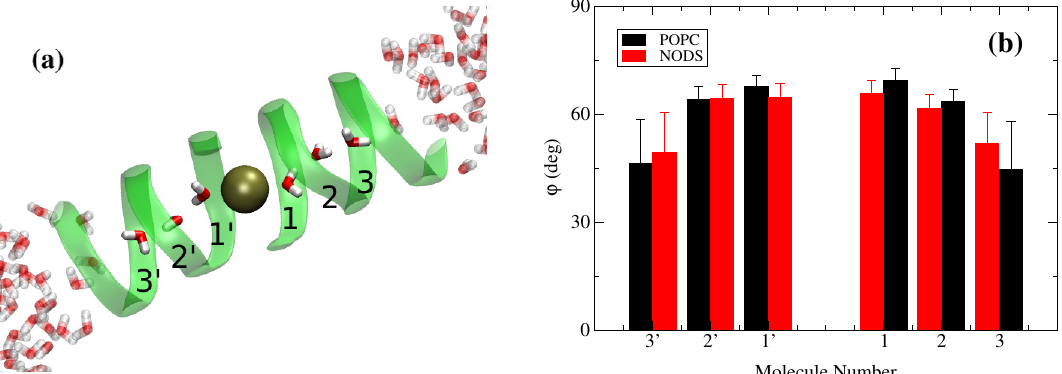
Figure 4. Water molecules inside the channel with K + located at the center of gA. ( a ) Structure showing K + positioned in the center of gA with aligned water molecules (lipids not shown); and ( b ) average orientation of water molecules. The orientation is defined as the angle between the dipole vector and the x-y -plane. Labels for water molecules are shown on the